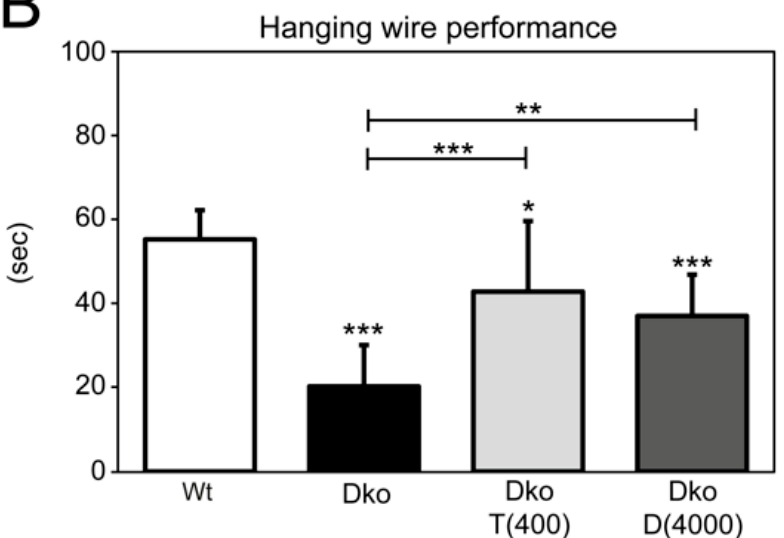
Figure 3. Transient early TH-analog treatment improves locomotion in adulthood. Dko mice re- ceived daily injections with saline, 400 ng/g bw Triac (Dko + T (400)) or 4000 ng/g bw Ditpa (Dko + D (4000)) between P1 and P20. Thereafter, treatment was ceased, and locomotor behavior was